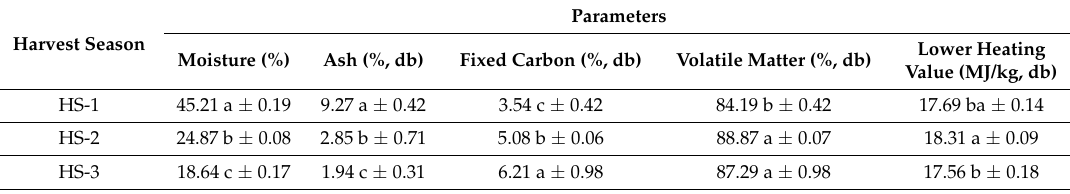
Table 2. Proximate analysis and lower heating value of the investigated Sida hermaphrodita biomass. Harvest